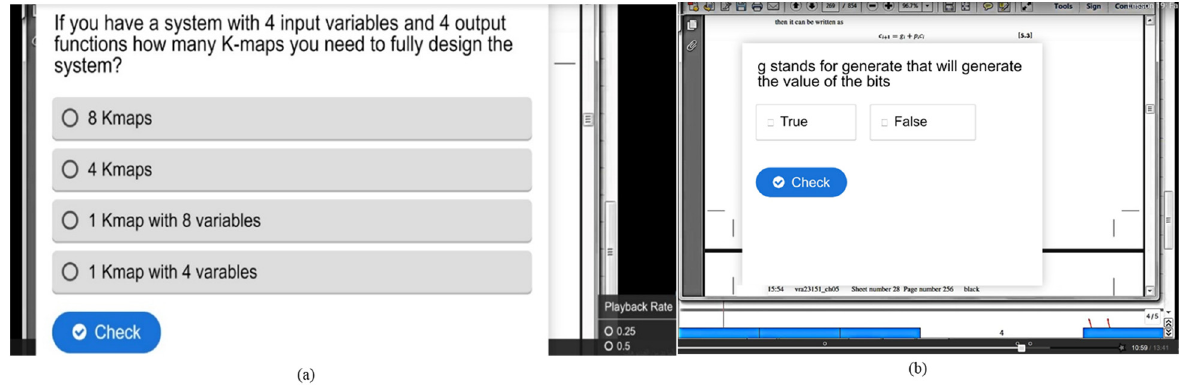
Figure 4. ( a ) Screenshot of a single-choice question in the video. ( b ) Screenshot of a true-or-false question in the video.